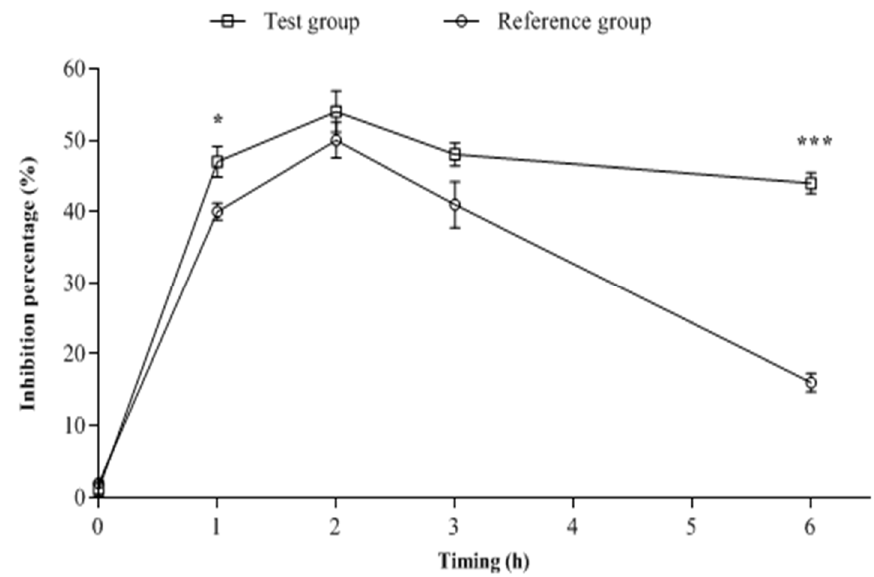
Figure 3. Effects of plasma samples collected from animals treated with AMX/Clav (reference group) or with AMX/Clav/1,8-cineole (test group) against E. coli ESBL-producing strain growth (inhibition%). *: statistically significant difference compared to reference group ( p < 0.05); ***: statistically significant difference compared to reference group ( p < 0.001).